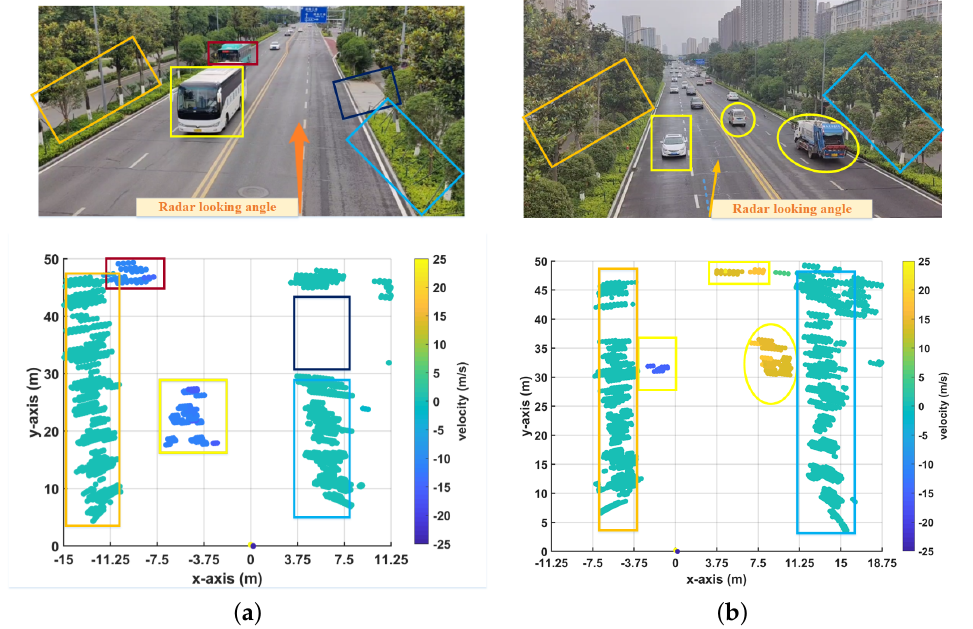
Figure 27. Urban traffic road imaging based on millimeter-wave radar. ( a ) Traffic scene 1 and combined moving and static targets imaging result. ( b ) Traffic scene 2 and combined moving and static targets imaging result.